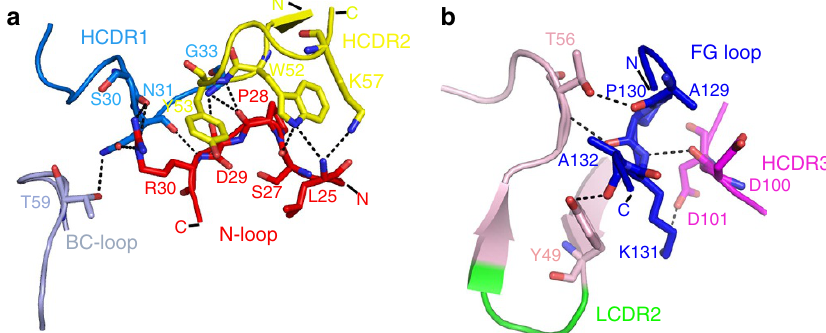
Figure 2 | The atomic interaction details at the binding interface of PD-1 nivolumab-Fab complex. Detailed interactions of nivolumab binding to the N-loop, BC loop ( a ) and FG loop ( b ) of PD-1. Residues involved in the hydrogen bond interaction are shown as sticks and labelled. Hydrogen bonds are shown as dashed black lines.